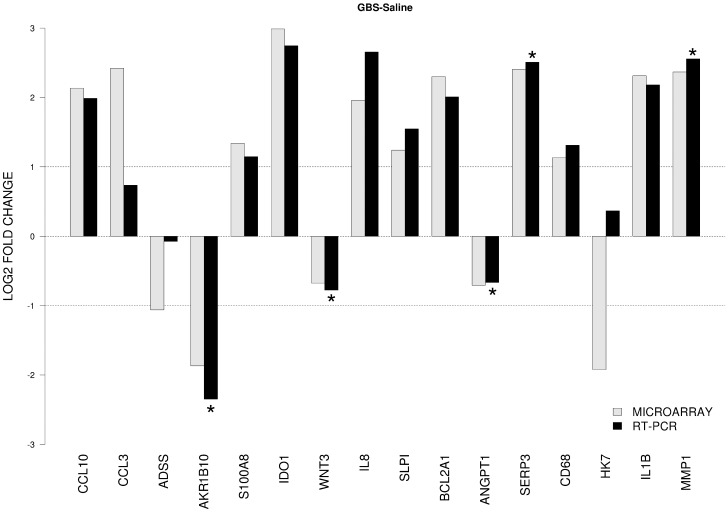
IPA diagrams were generated for A) neutrophil chemotaxis Gene Ontology gene set and B) NF-κB, a transcription factor predicted to be activated by IPA.Genes shown were filtered for interactions reported in humans only and presented by cellular localization. Direct and indirect interactions are shown by solid lines and dashed lines respectively. Green indicates gene downregulation and red depicts upregulation. White symbols indicate functionally associated neighboring genes that were not differentially expressed in the data. Color intensity represents the average of log2 fold change with brighter colors representing a more significant difference between GBS and controls. Symbols for each molecule are presented according to molecular functions and type of interactions.